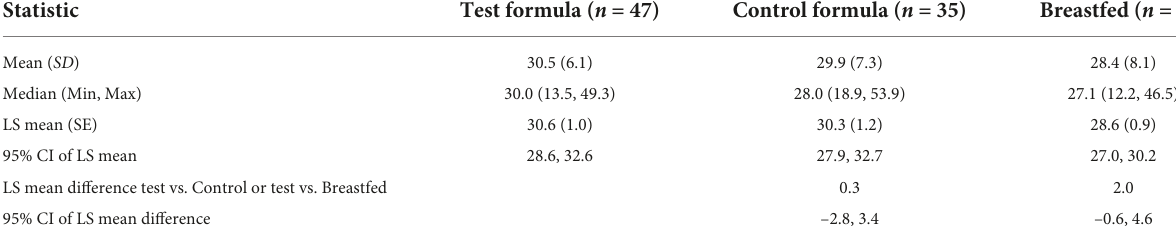
TABLE 4 Analysis of mean daily weight gain (grams) (PP